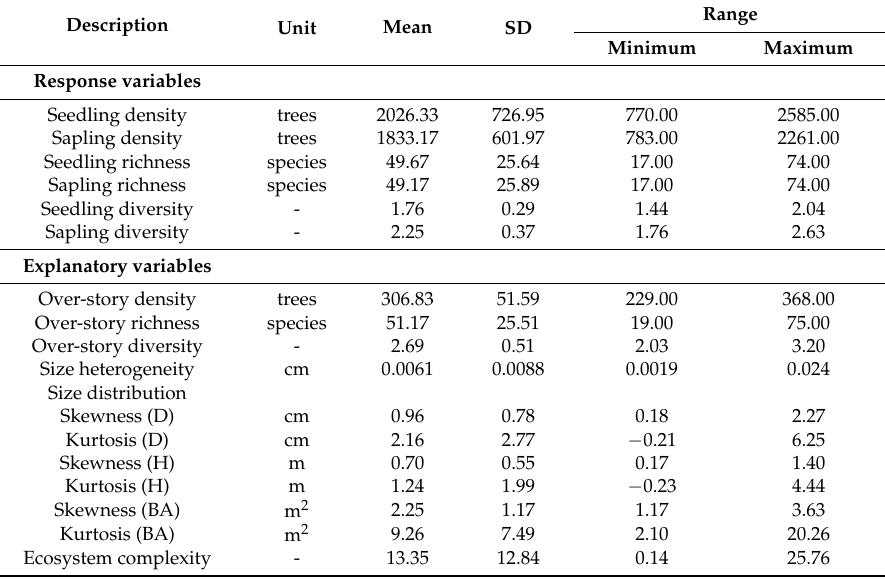
Table 3. Variables of overstory structure and natural